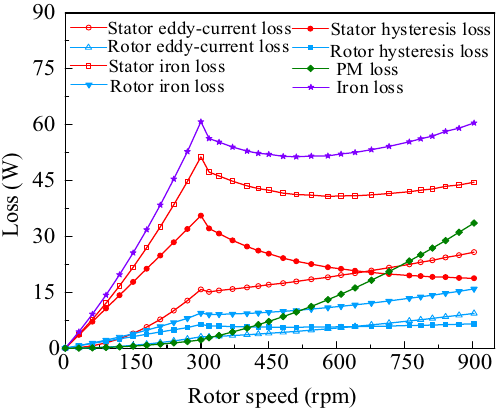
Figure 11. Iron loss and PM loss of BPMEM under the flux-weakening